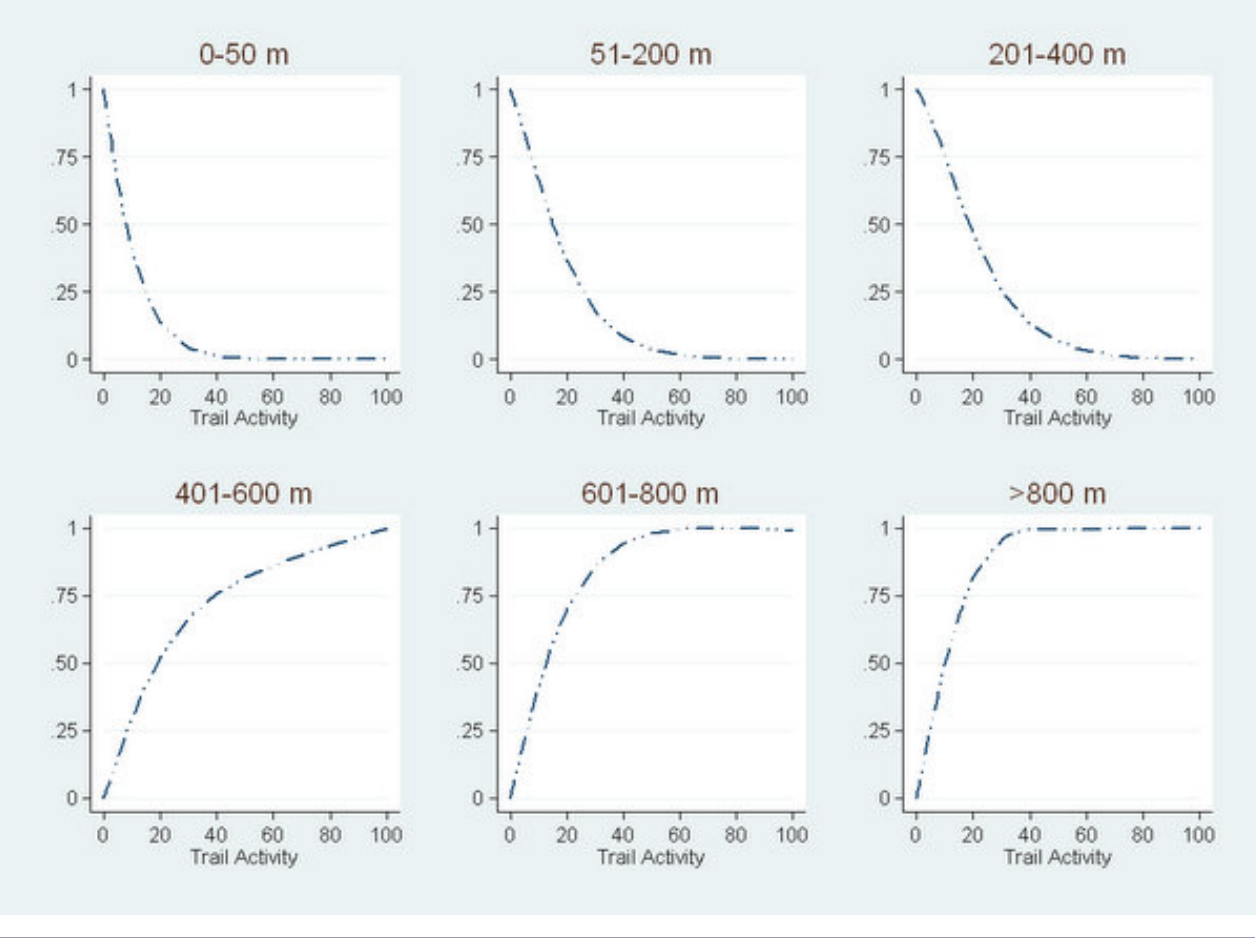
Fig. 2. Graphs of the change in wolf relative probability of use as a function of increasing trail activity within six ‘distance-to-trail’ categories. The x-axis is hourly trail activity and y-axis is relative probability of use. A linear stretch was used to scale the predicted values between 0 and 1 following Johnson et al.